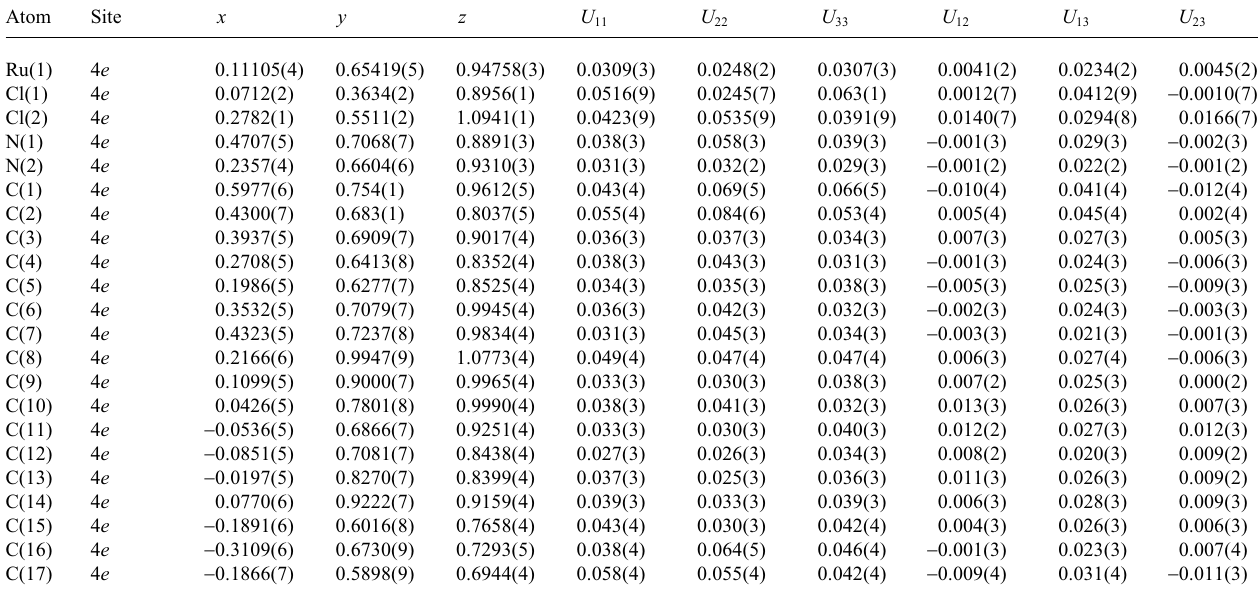
Table 3. Atomic coordinates and displacement parameters (in Å 2 ).